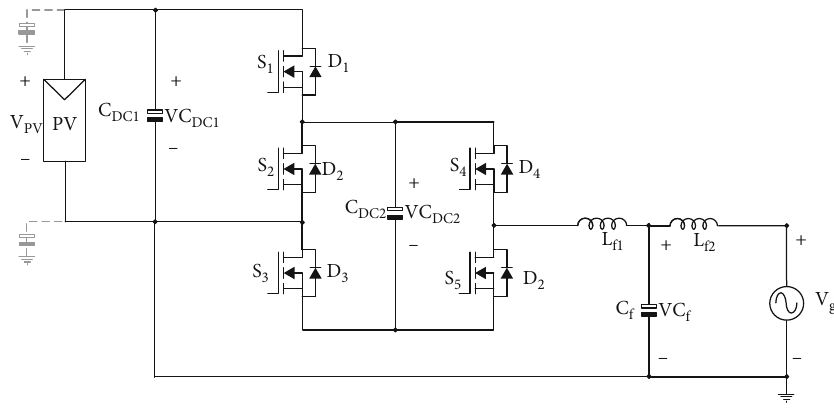
Figure 7: Virtual DC bus